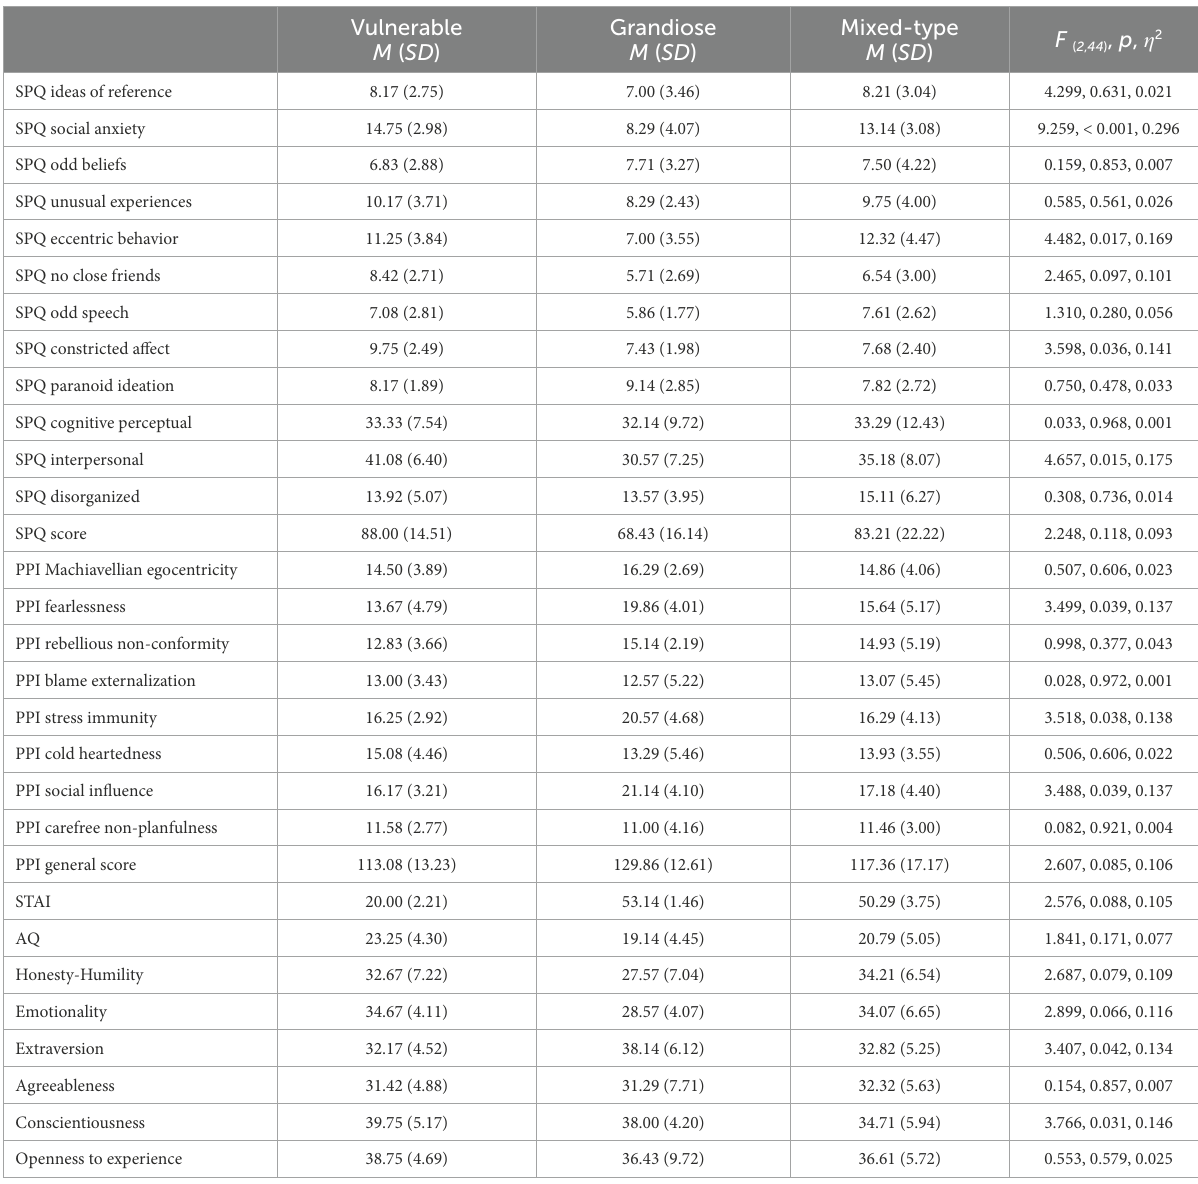
TABLE 2 Descriptive statistics for ANOVAs between the subtypes of narcissism.